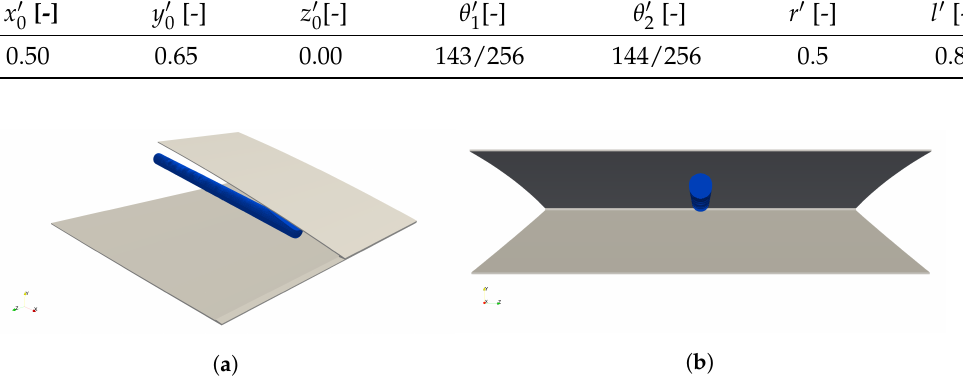
Figure 5. Initial placement of feature for the feature-mapping approach. ( a ) Isometric view. ( b ) Back